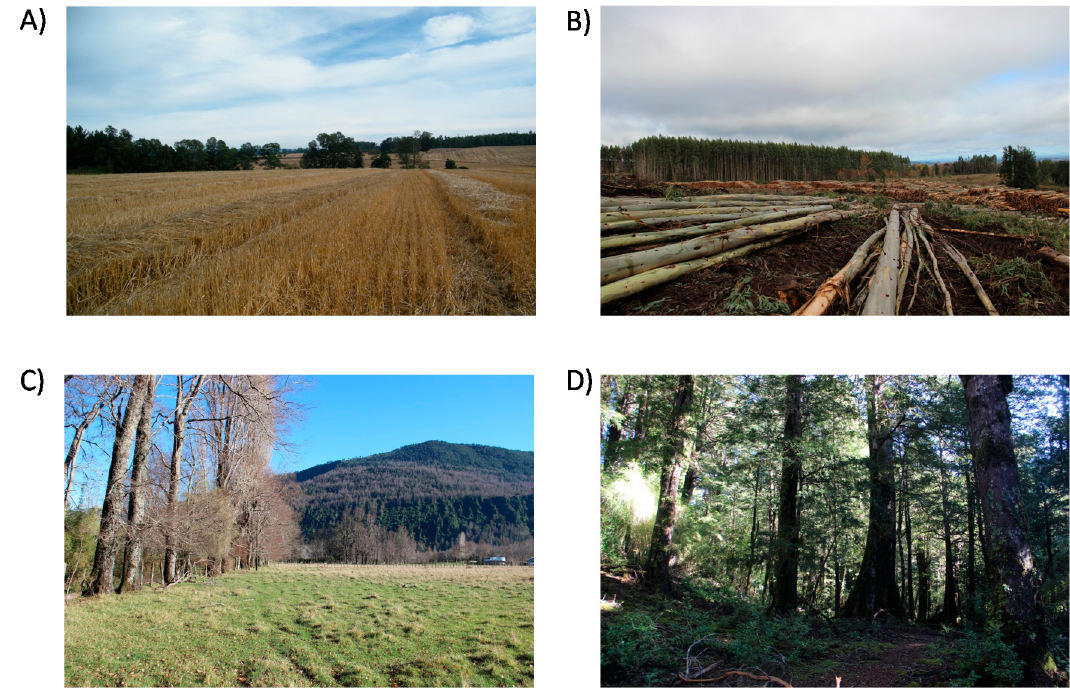
Figure 2. Examples of eye-level images used for four landscapes in the La Araucanía Region, south-central Chile: ( A ) Freire, ( B ) Lumaco, ( C ) Pucón, and ( D ) Curarrehue. See Appendixes A and B for the full list of images.